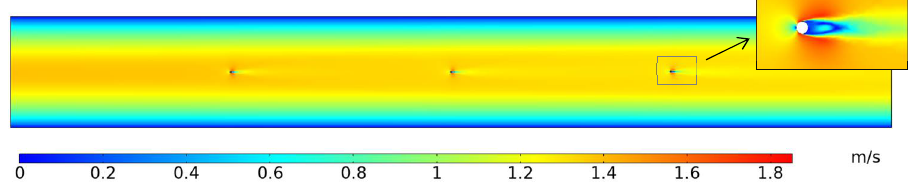
Figure 13. Velocity magnitude of the airflow inside the electrostatic sanitizer (ESS).